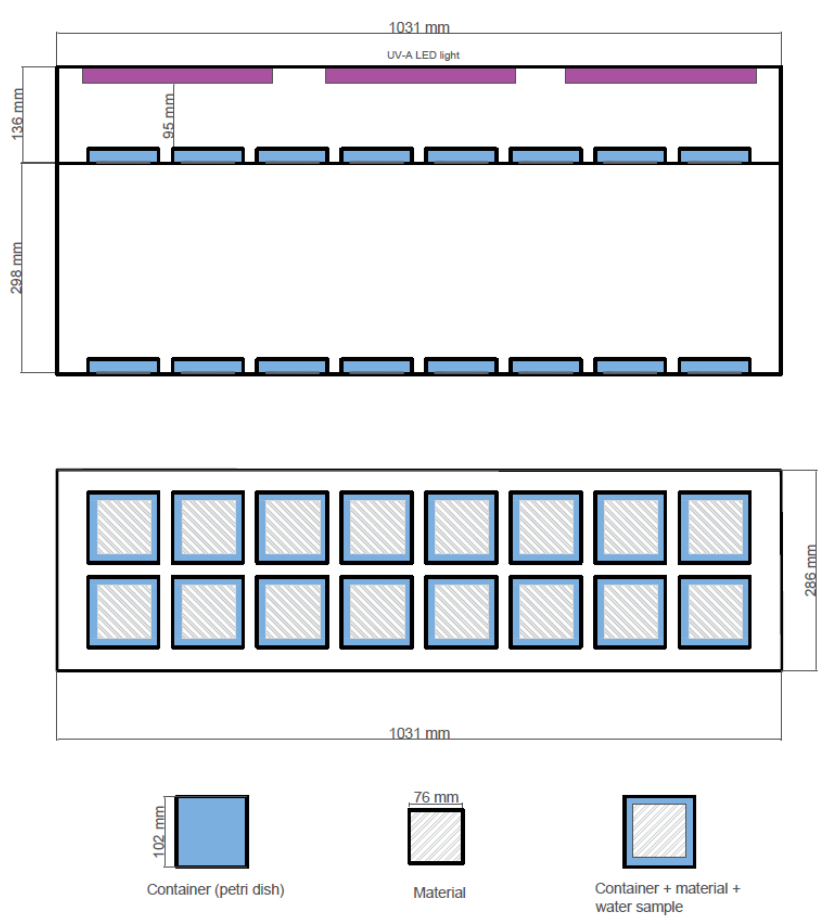
Figure 2. Scheme of the reactor used in the photocatalytic test.